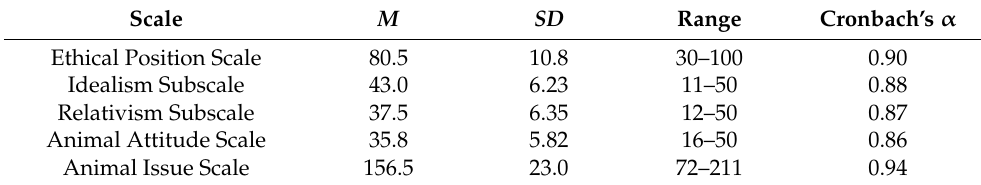
Table 2. Psychometric properties for scales and their subscales (N = 450).